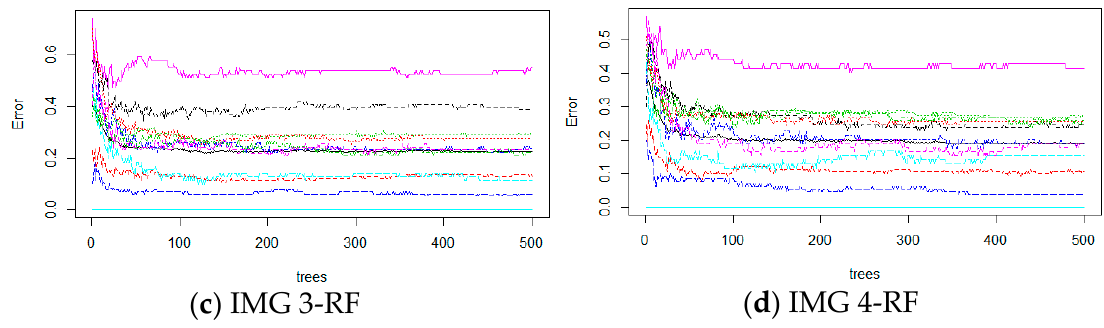
Figure 5. Out-of-bag error rate (OOB) errors versus ntree values: ( a ) IMG 1-RF; ( b ) IMG 2-RF; ( c ) IMG 3-RF; ( d ) IMG 4-RF.